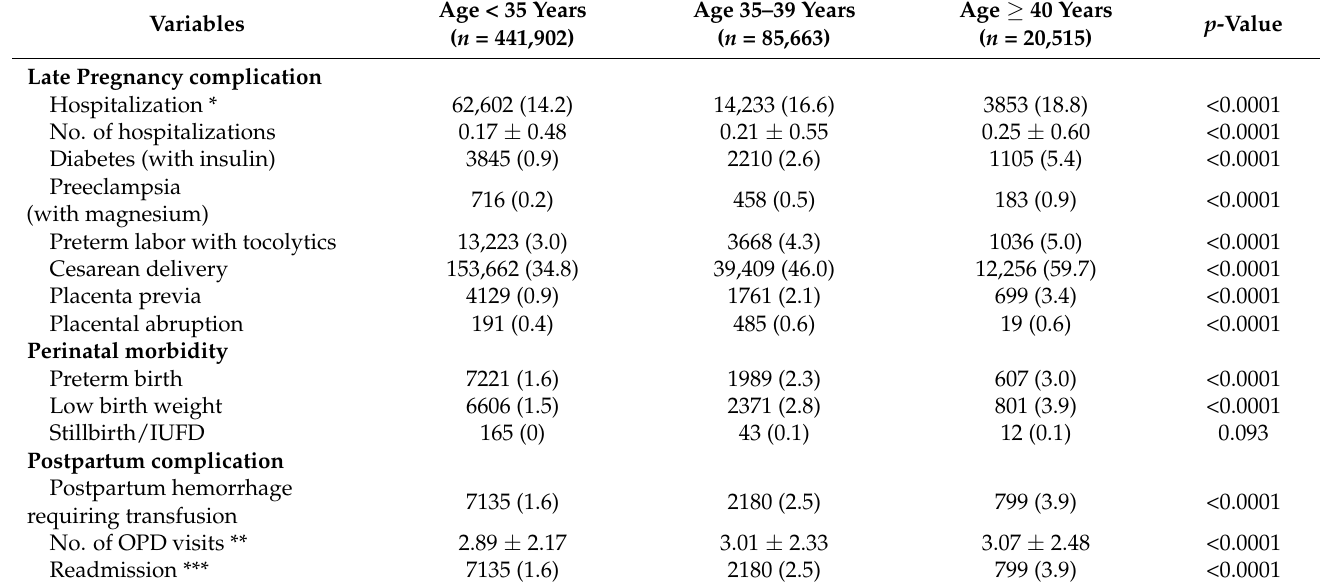
Table 2. Obstetric outcomes by maternal age.